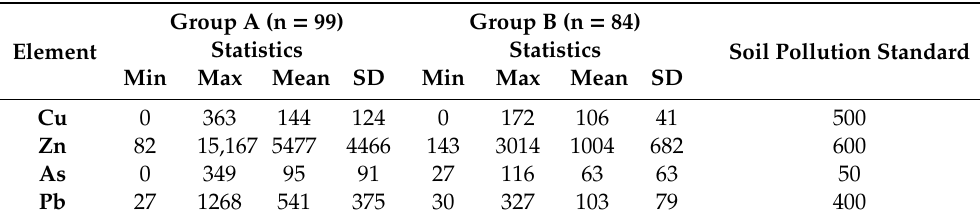
Figure 2. Sample location of each group and geologic map in Gagok mine, South Korea. Table 2. Descriptive statistics of heavy metal concentration (unit: ppm (mg / kg)) in soils derived from XRF analysis and soil pollution standard [8].